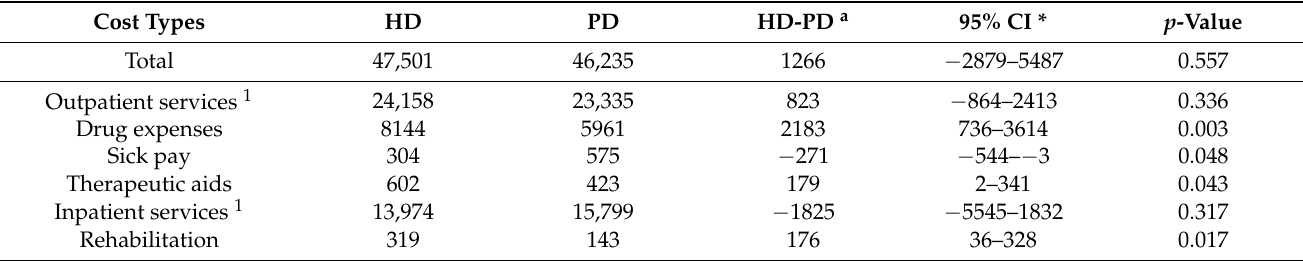
Table 2. Annual costs per patient (in EUR) according to type of dialysis (HD or PD) (HD: n = 436; PD: n =